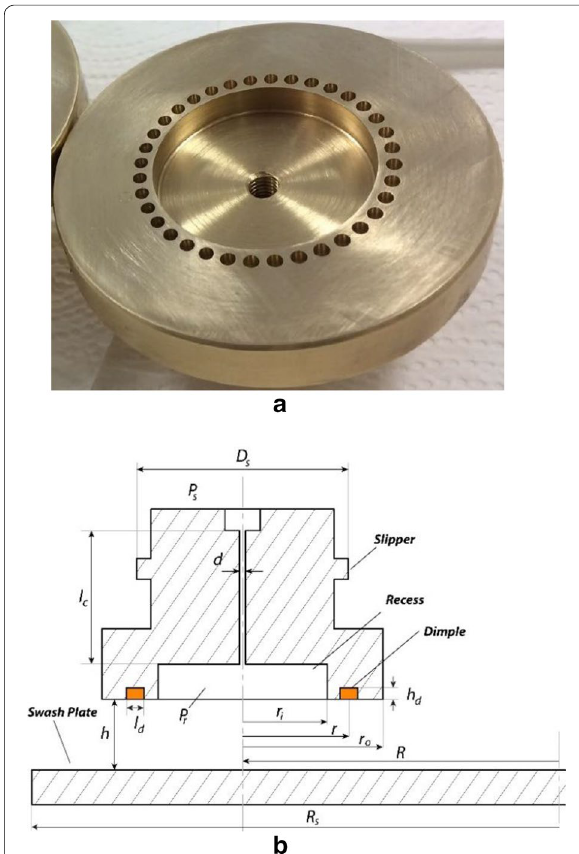
Figure 3 a Slipper used in the current study and b geometric definitions